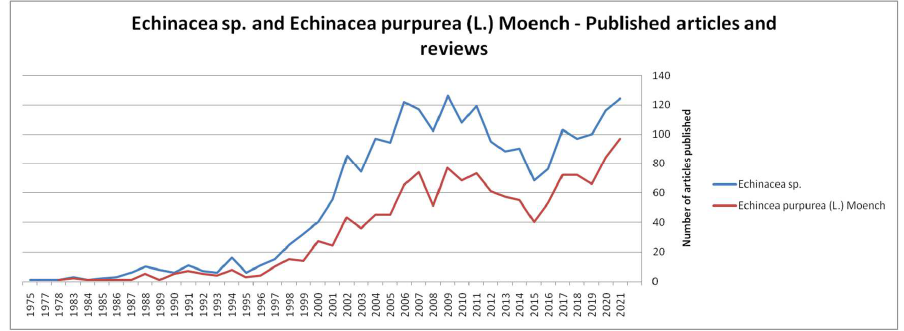
Figure 1. Evolution of the number of articles and reviews about Echinacea sp. and Echinacea purpurea (L.) Moench [9,10]. The flowers are grouped in inflorescences, the terminal anthodes are pink, pale red to deep red. At the base of the inflorescence there are sharp bracts that, when mature, lignify and become spiky. The sterile ray flowers are pink, located at the edge of the in- florescence, and the ligules are 5–7 cm long and 0.5 cm wide. The disk flowers are tubu- lar, orange-brown, bisexual and are placed inside the inflorescence. The fruits are achene, white-gray, edged, with four edges and teeth at the top. It blooms in June–July [14–18]. Invasive weeds are a common problem for Echinacea crops. Chemicals such as herbicides are one of the most efficient weed control tactics. Herbicides are harmful to the Echinacea's physiological and morphological processes [19].